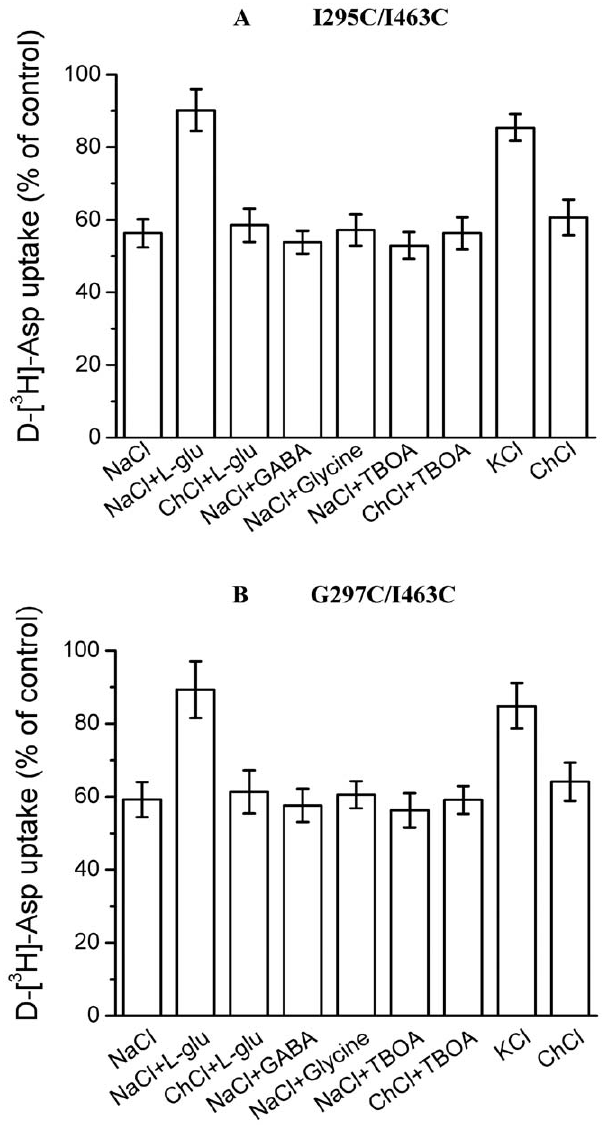
Figure 4. Effect of the composition of the external medium on the inhibition of double cysteine mutants by CuPh. HeLa cells expressing double cysteine mutants were preincubated for 5 min in the presence and absence of 200 m M CuPh. The indicated preincubation solutions contained NaCl, NaCl + 1 mM L-glutamate, ChCl + 1 mM L- glutamate, NaCl + 1 mM GABA, NaCl + 1 mM glycine, NaCl + 20 m M TBOA, KCl, choline chloride. Values are given as percent of control (preincubation without CuPh) and represent the mean 6 S.E. of at least three different experiments done in triplicate. ( A ) I295C/I463C double cysteine mutants. ( B ) G297C/I463C double cysteine mutants. I463C by MTSET (Fig. 5C). Glutamate has no effect on the inhibition of transport of I295C and G297C by MTSET (Fig. 5A